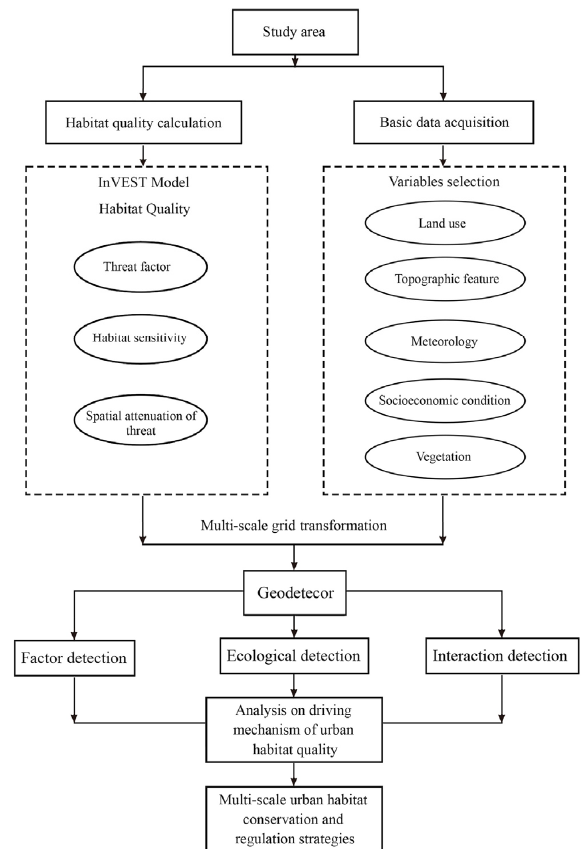
Figure 2. Workflow steps in our analysis.